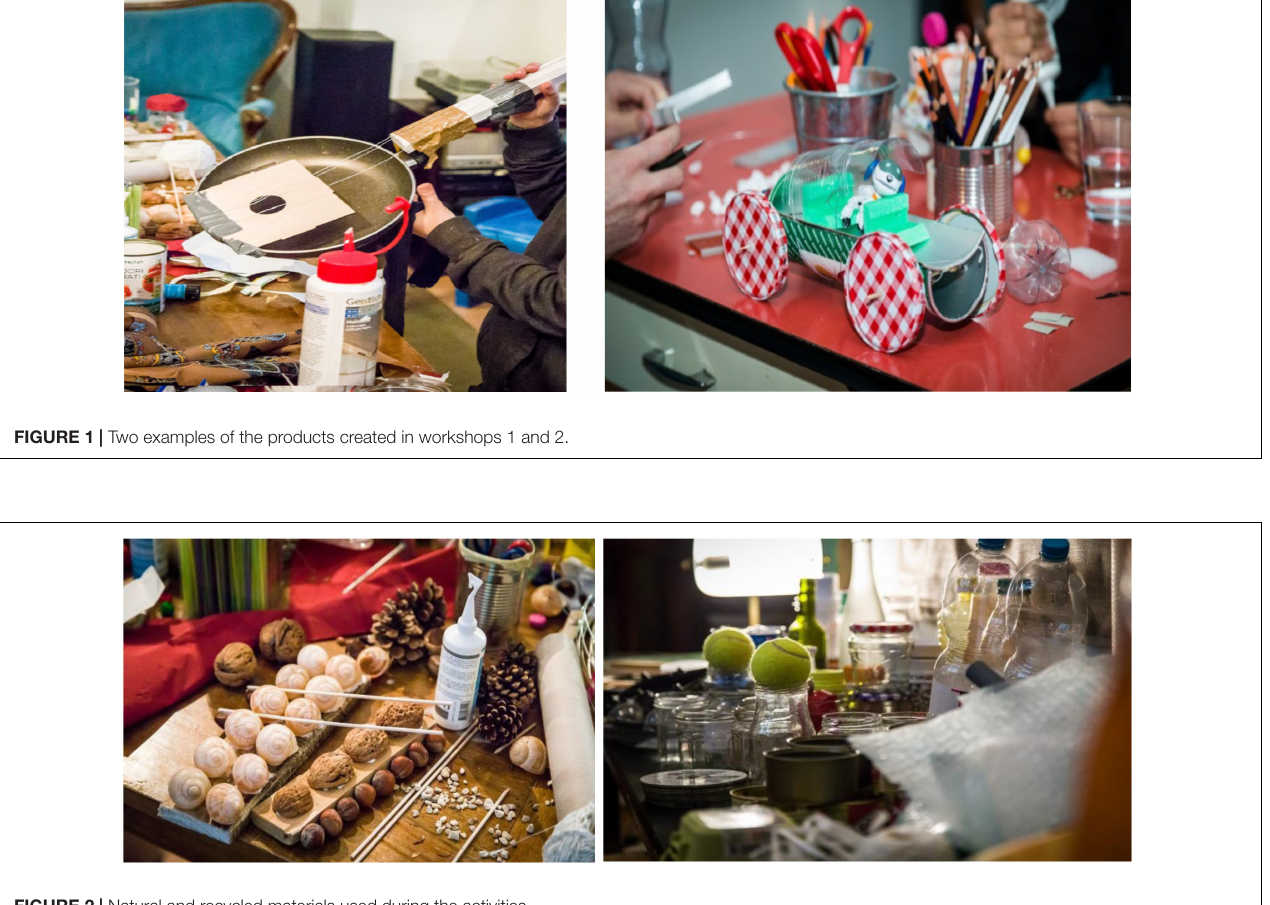
FIGURE 2 | Natural and recycled materials used during the activities.